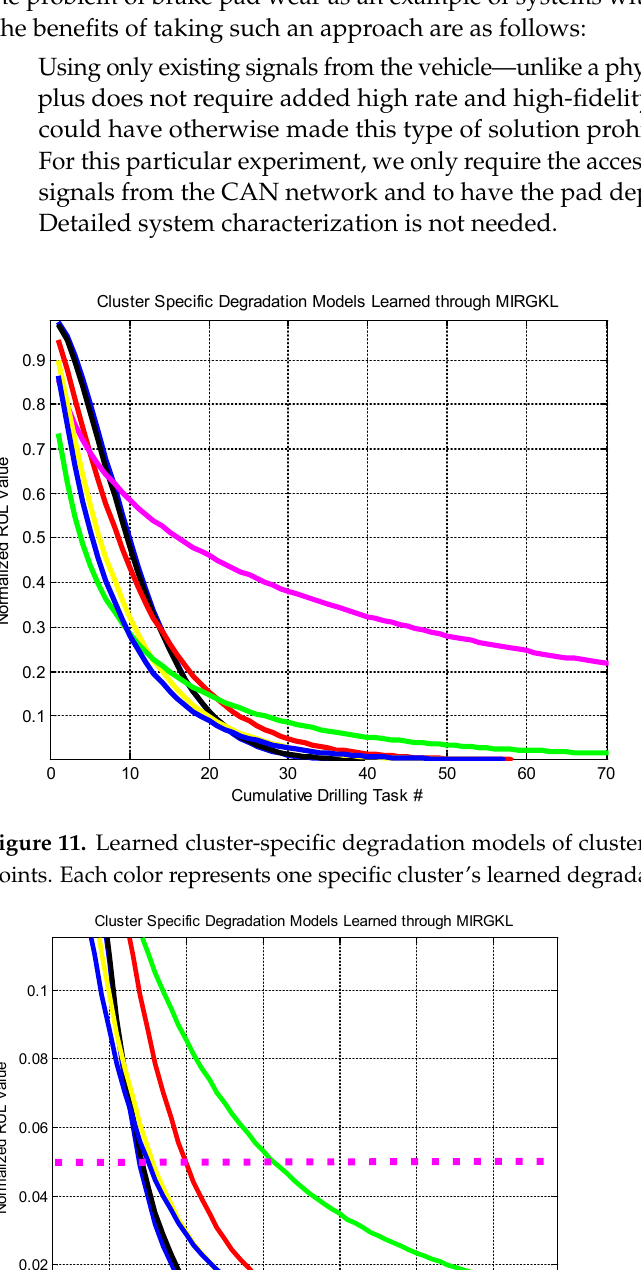
Figure 10. Normalized inferred RUL vs. predicted RUL for drill-bits #9~#16 in a delayed online setup.